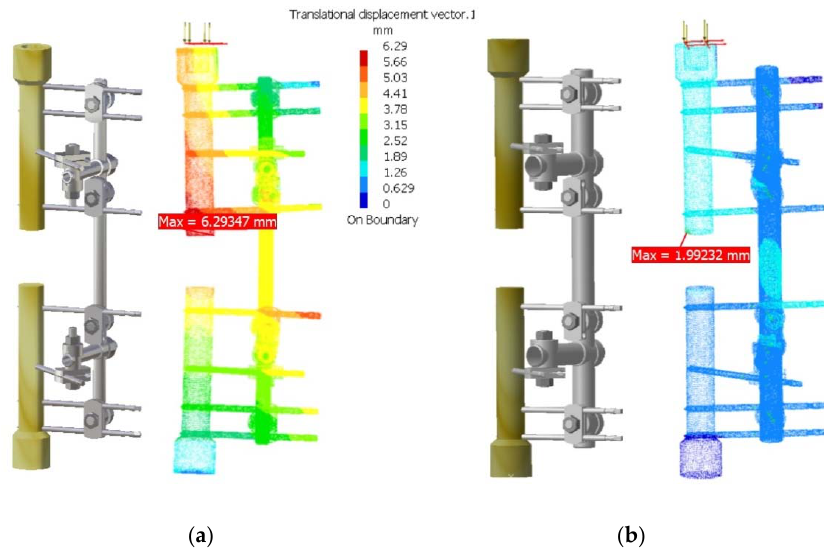
Figure 19. Initial ( a ) and optimized ( b ) design of external fixation device. The initial and optimized design of external fixation device shown with displacement field are given in Figure 18. The maximal displacement of the design is marked. This dis- placement represents the maximal resulting displacement of proximal bone segment D p , and at the same time, it is optimization constrain g 1 (x).